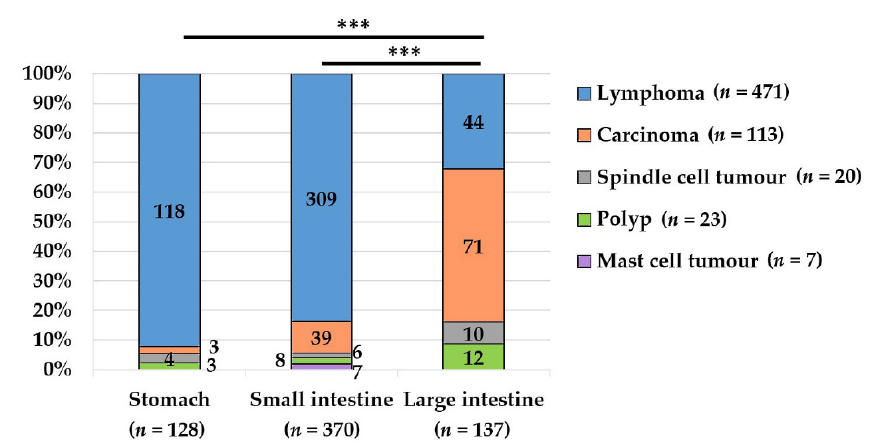
Figure 2. The frequency of different gastrointestinal neoplasms varies depending on the anatomical site. The differences between the stomach and large intestine (***, p < 0.001), as well as between the small intestine and large intestine (***, p < 0.001), were significant. Carcinomas occurred more frequently in the large intestine than in the small intestine or the stomach (intestine NOS and lymphomas in more than one sample are not included in the graph).